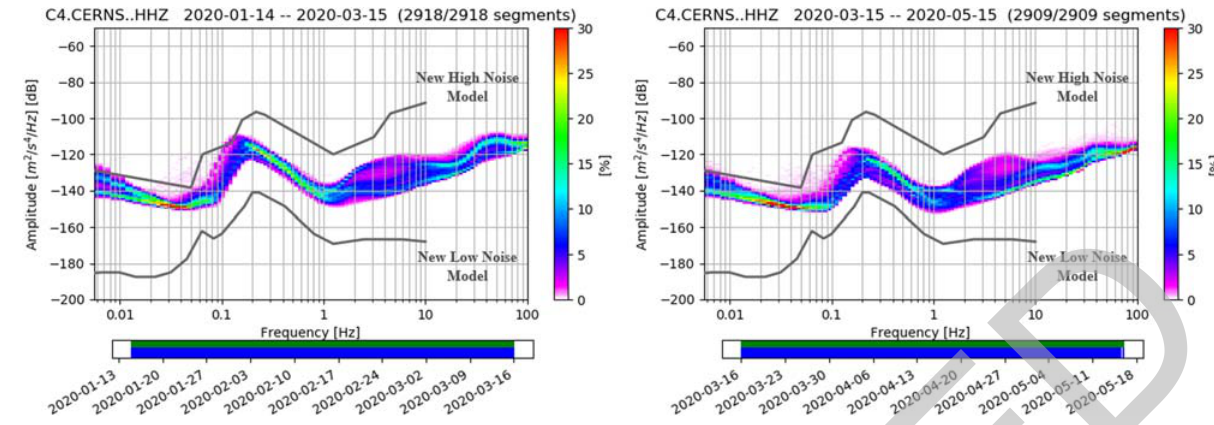
Figure 8: Probabilistic Power Spectral Density of CERN Seismic Station at the surface ( CERNS ) calculated over a period of 2 months before ( left graph ) and 2 months after ( right graph ) the CERN COVID - 19 closure.